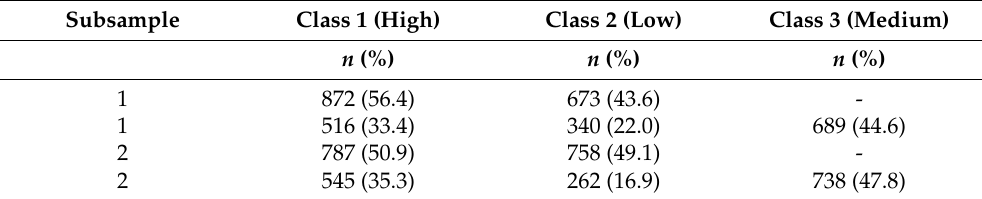
Table 3. Distribution across the classes for two and three classes for subsample 1 and